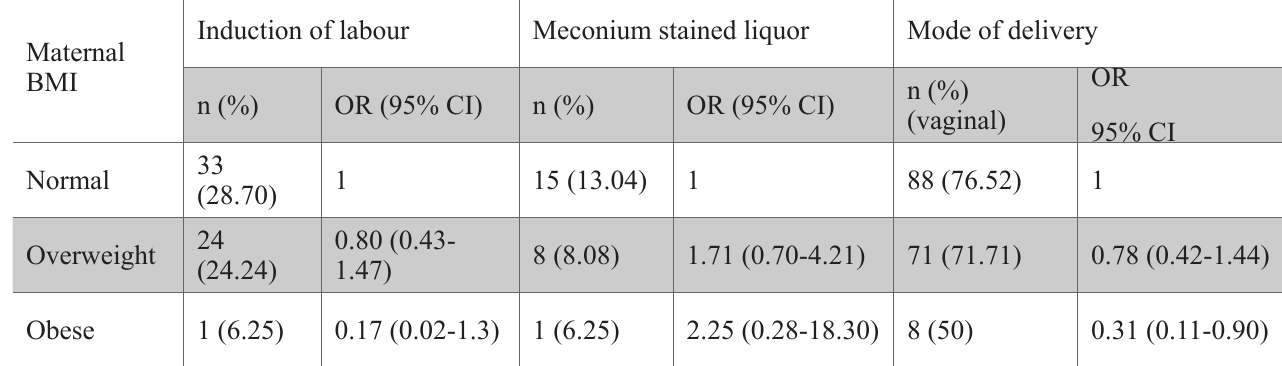
Table 2: Comparison of obstetrical outcomes among study and reference groups